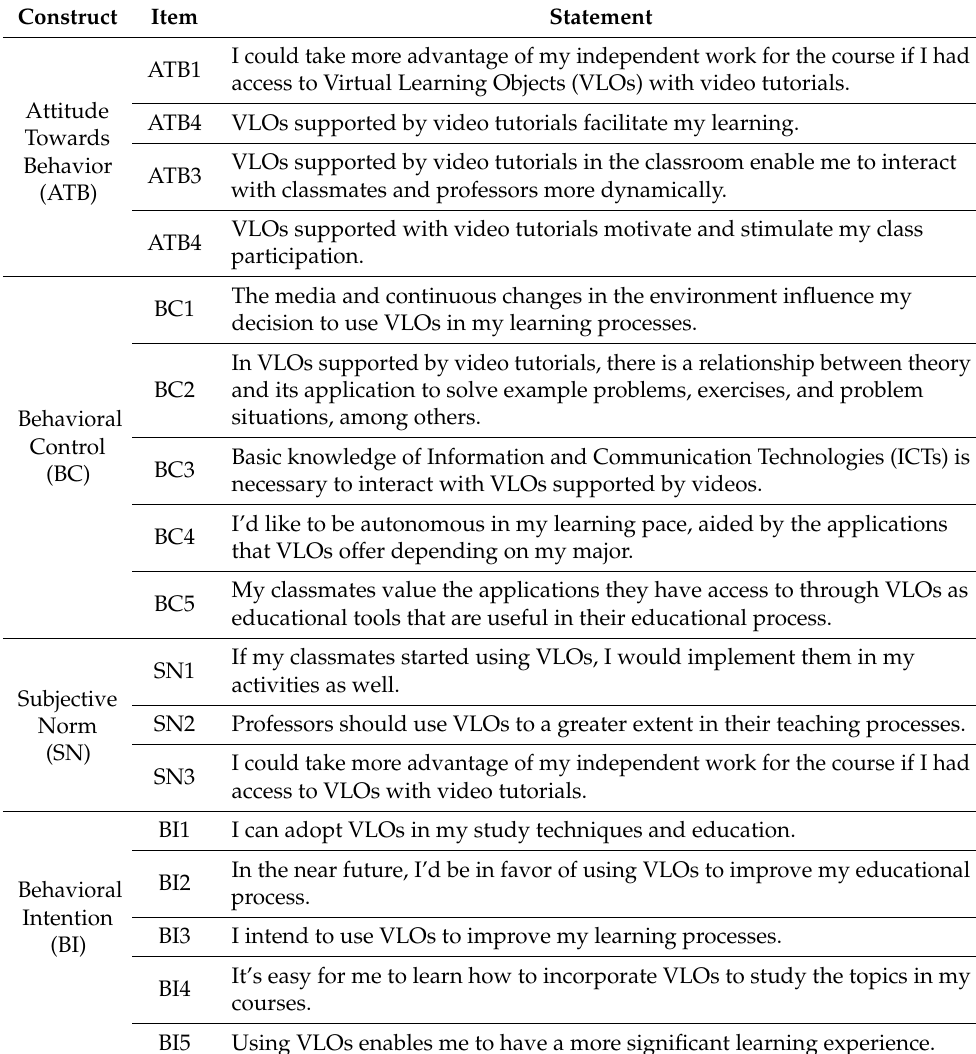
Table 1. Questions associated with each